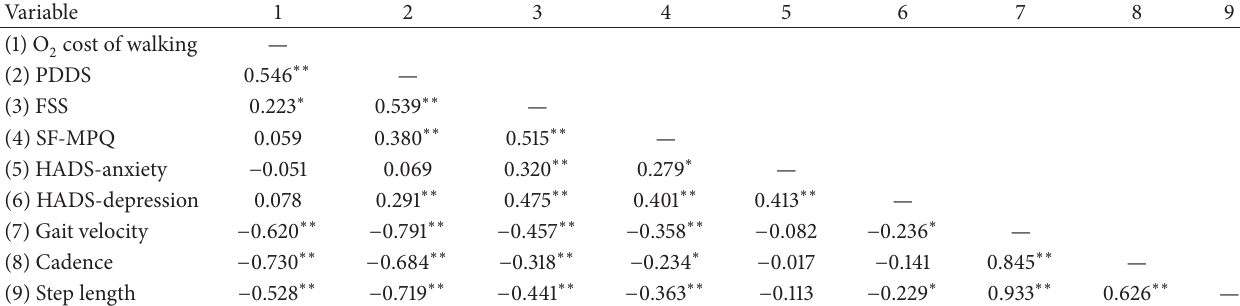
Table2:Pearsonproduct-momentcorrelations( 𝑟 )amongoxygencostofwalking,Patient-DeterminedDiseaseStepsscores,andsymptomatic and gait variables in 82 persons with MS.